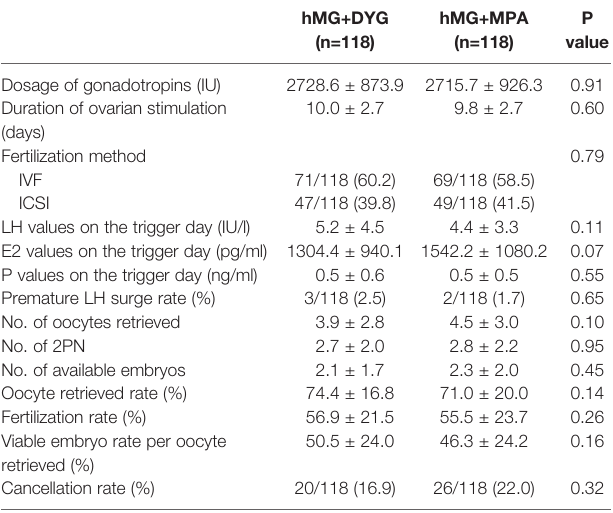
TABLE 2 | Cycle characteristics of women treated with the hMG+DYG and hMG+MPA protocols.